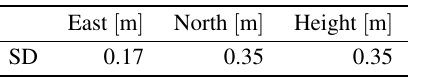
Table 6. Standard deviations of the UAV position from